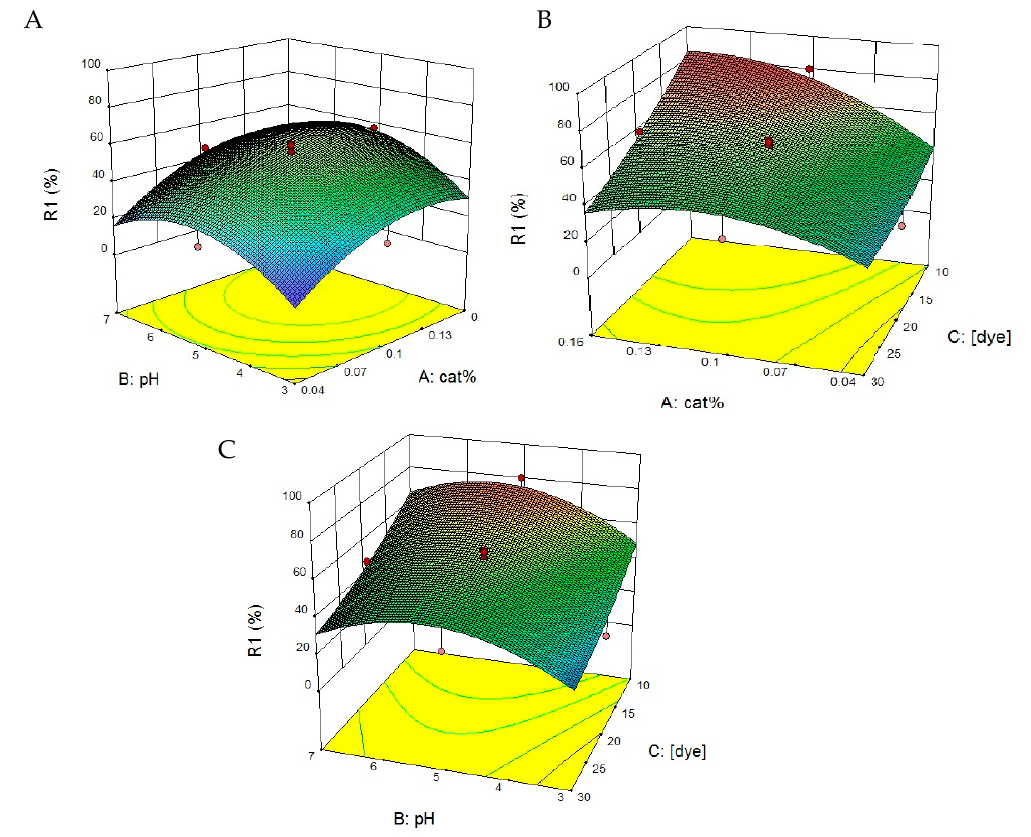
Figure 9. Response surface plots showing the interaction of independent variables on each other for degradation of RR198 by ZnO-Nd under UV light (( A ) catalyst dosage and pH, ( B ) catalyst dosage and initial dye concentration, and ( C ) pH and initial dye concentration)